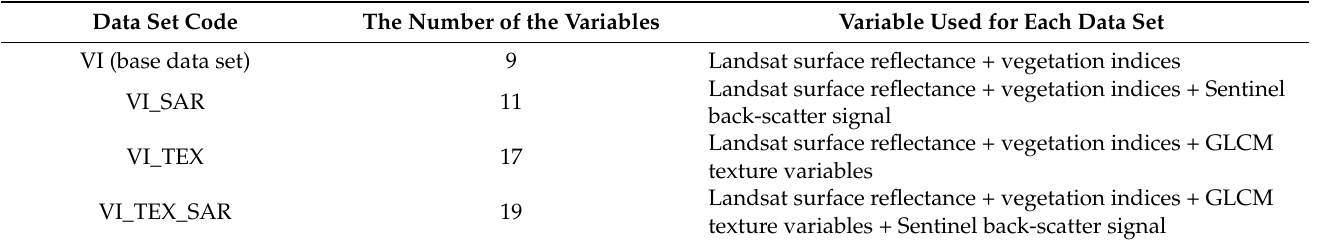
Table 2. Codes for the data sets used in this study and the variables used for each data set. These code names are used in the following text and